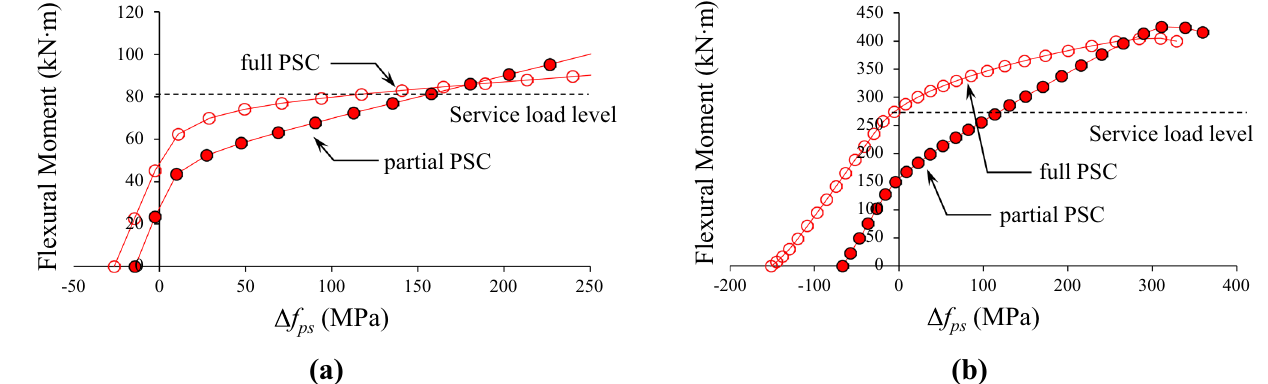
Fig. 8 Effect of partial prestressing ratio on D f ps . a PSC members with a low level of reinforcing index (RS1A series) and b PSC members with a high level of reinforcing index (RS7A